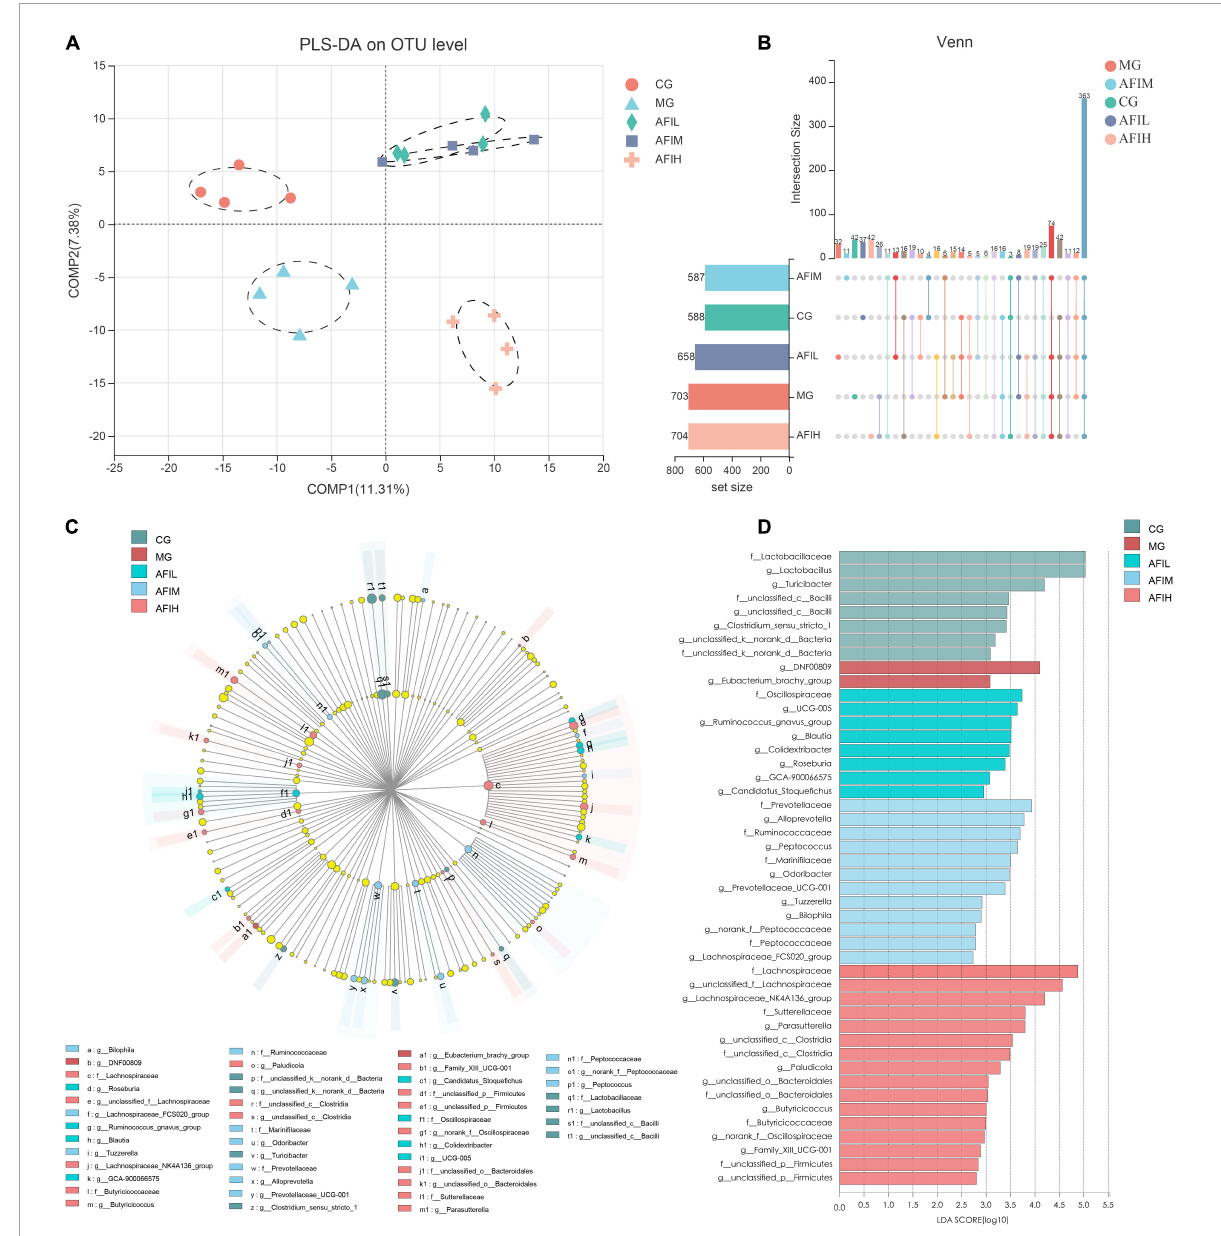
FIGURE5 The effect of AFI on the intestinal microbiota. (A) Partial least squares-discriminant analysis (PLS-DA) of the OTUs in the five groups. (B) Advanced venn diagram (UpSet) results for the transcriptome data from the four comparisons. (C) Significantly different bacterial taxa at the family to genus levels. (D) Significant differences were tested by linear discriminant analysis effect size (LEfSe) analysis, with linear discriminant analysis (LDA) scores of > 2 and p values of < 0.05. The taxa enriched in the five groups showed positive LDA